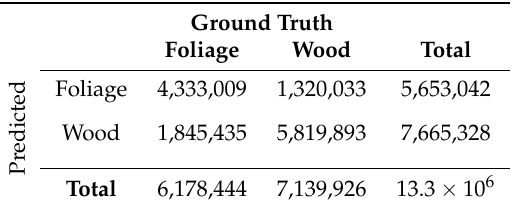
Table 1. Confusion matrix evaluating the classification